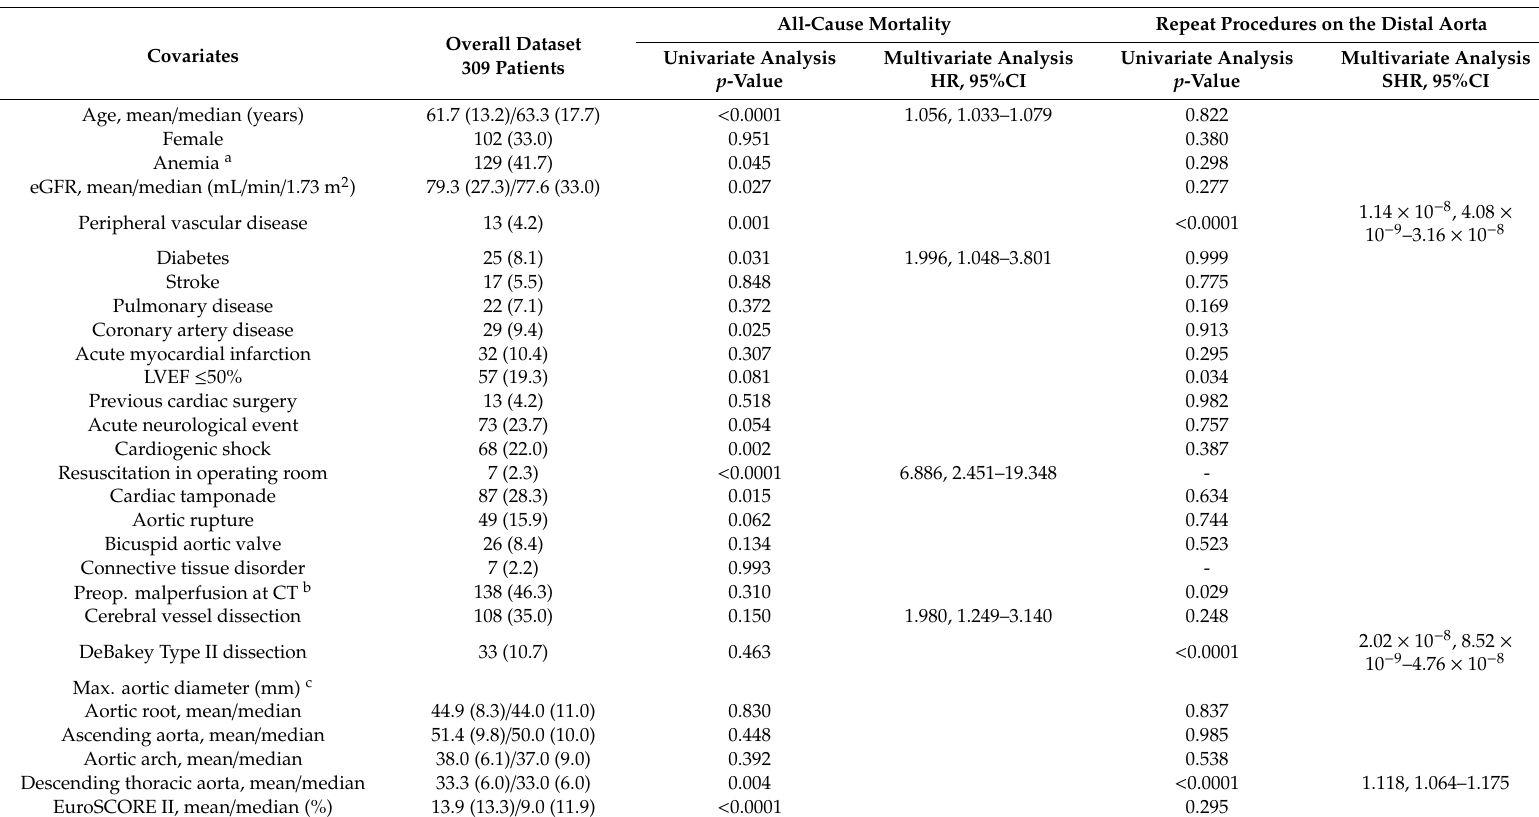
Table 1. Baseline characteristics and predictors of outcome in patients who underwent surgical repair for type-A aortic dissection. Risk estimates refer to independent predictors of adverse